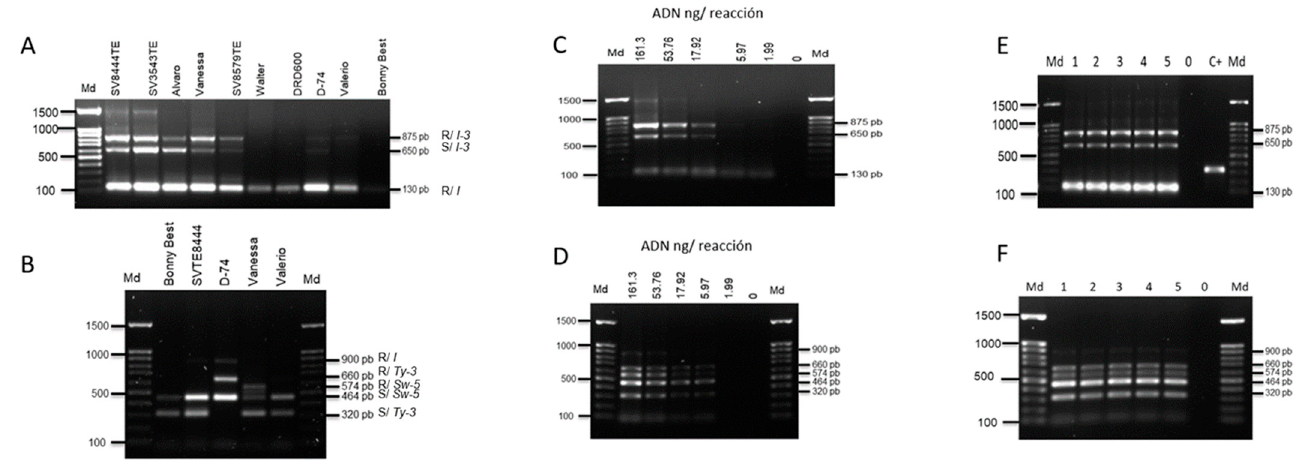
Figure 4. Evaluation of dynamic range and specificity/selectivity of optimized PCR protocols. Specificity/selectivity: ( A , B ); dynamic range: ( C , D ); limit of detection: ( E , F ). Md, 100 bp molecular weight marker. R indicates resistant genotype and S indicates susceptible genotype. C+, positive process control (plasmid DNA).